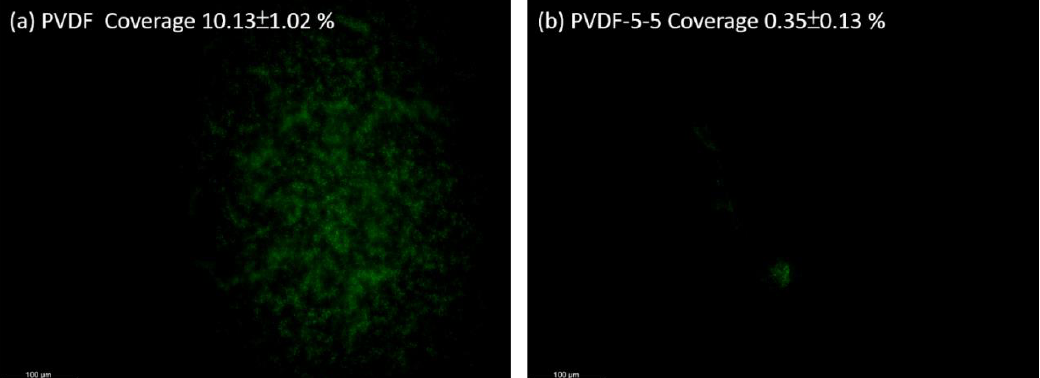
Figure 7. Fluorescent BSA attachment on the unmodified PVDF ( a ) and PVDF-5-5 ( b ). The membrane was exposed in the BSA solution for 3 h in PBS buffer. Scale bar: 100 µm.